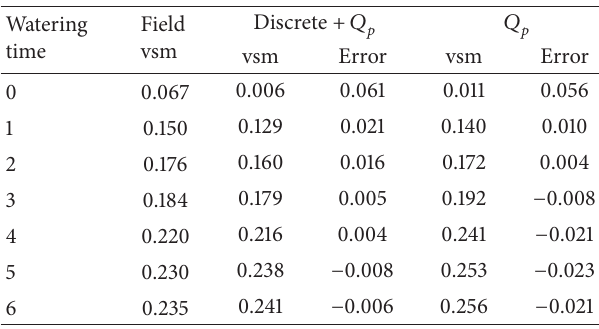
Table 1: Retrieved volumetric soil moisture and its